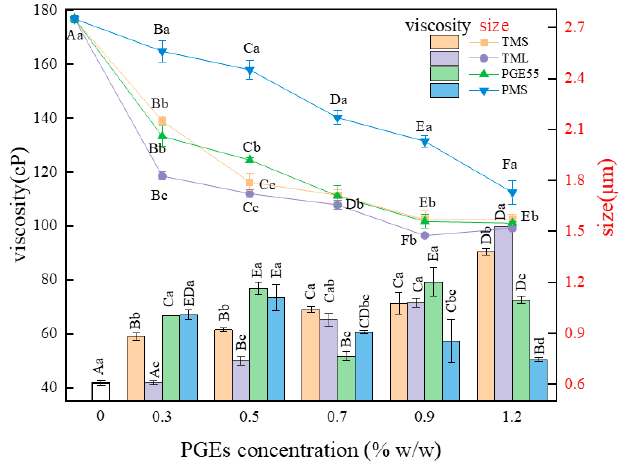
Figure 1. Effect of different PGEs on particle size (the line) and viscosity (the bar) of RDC emulsions. Uppercase letters indicate differences between concentrations, and lowercase letters indicate differences between PGEs.